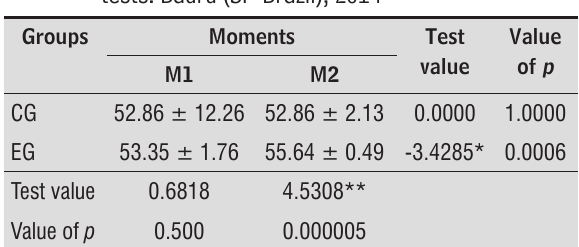
Table 2 - Mean and standard deviation of the Berg test in both evaluation moments (M1 and M2) regarding the groups (CG and EG) and results of statistical tests. Bauru (SP-Brazil), 2014